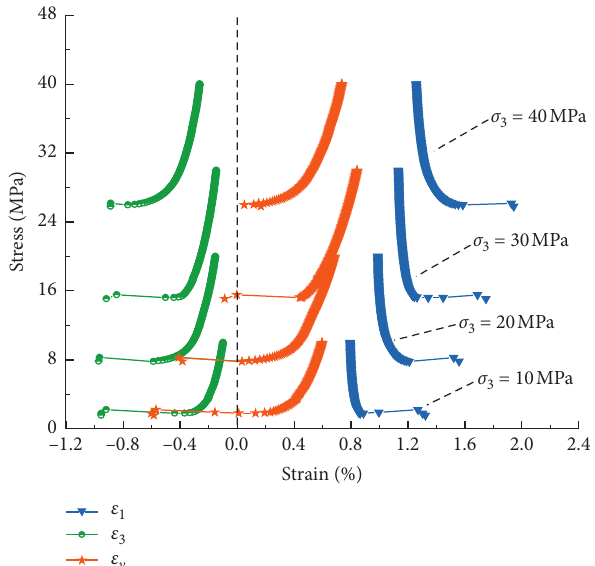
Figure 6: Relationship curve of confining pressure, axial strain, radial strain, and volume strain of sandstone under the unloading condition.